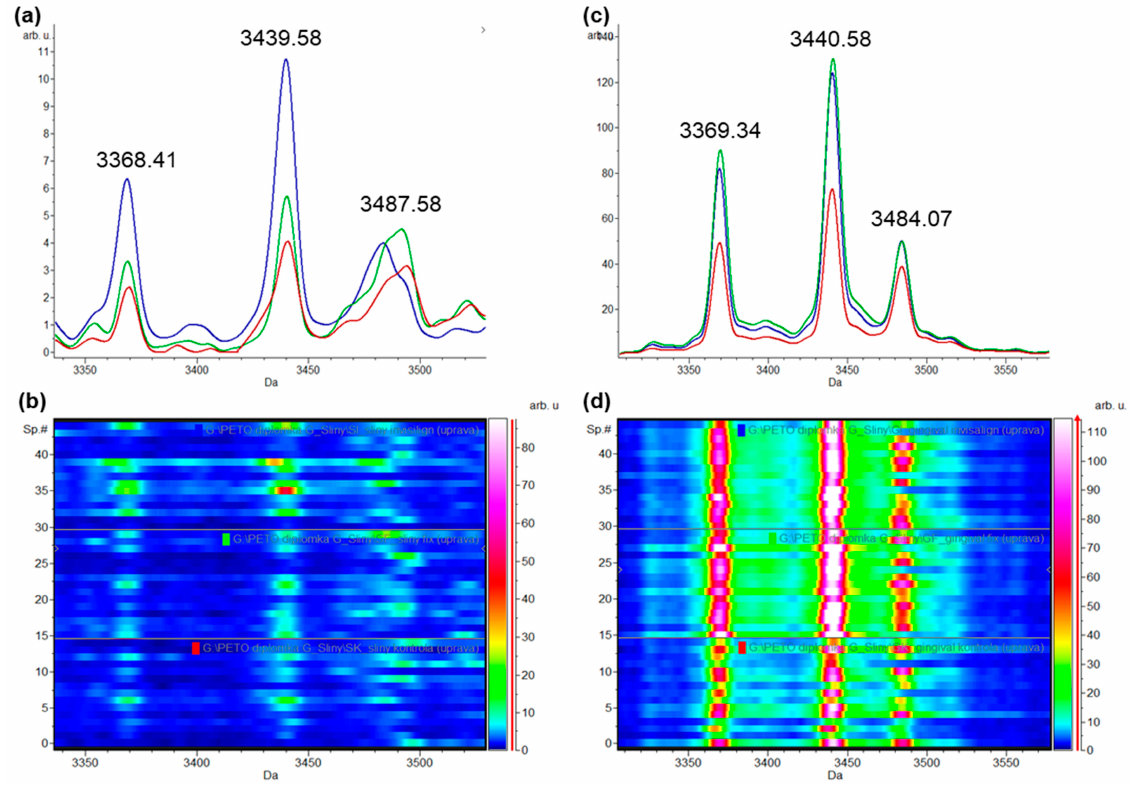
Figure 4. Comparison of the total average spectra of three highly intense peaks matching with human neutrophil peptides HNP-1 ( m/z = 3442), HNP-2 ( m/z = 3371), and HNP-3 ( m/z = 3486) displaying differential expression levels in the control (red), FOA (green), and IN (blue) groups between saliva ( a ) and GCF ( c ) samples. Corresponding gel view representation (rainbow-scale colour scheme) of the same region between saliva ( b ) and GCF ( d )